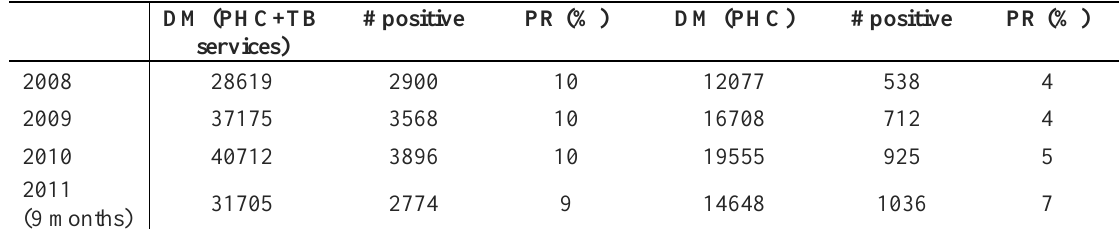
Table 1. Smear microscopy results in Tajikistan